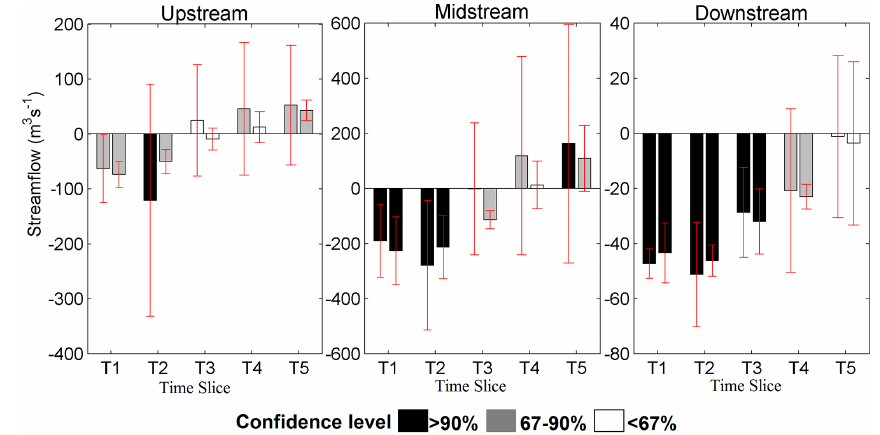
Figure 10. Change in ensemble mean of Q clim from the baseline period for RCP4.5 (first bar of every time slice of all the plots) and RCP8.5 (second bar of every time slice of all the plots) scenarios at each time slice (T1: 2010–2020, T2: 2021–2040, T3: 2041–2060, T4: 2061–2080 and T5: 2081–2100).